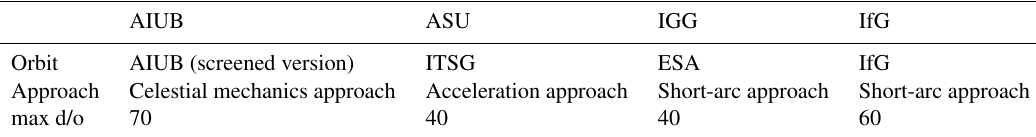
Table 6. Comparison of the variance (mm) of the individual ocean mass time series (main diagonal) and the RMSE (mm) between two solutions (off-diagonal). The results are based on the time series of Fig. 2. GRACE AIUB ASU IGG IfG GRACE 6.6 5.1 2.8 4.0 5.2 AIUB 7.4 4.5 4.3 5.4 ASU 7.3 4.2 4.1 IGG 7.5 5.6 IfG 8.5